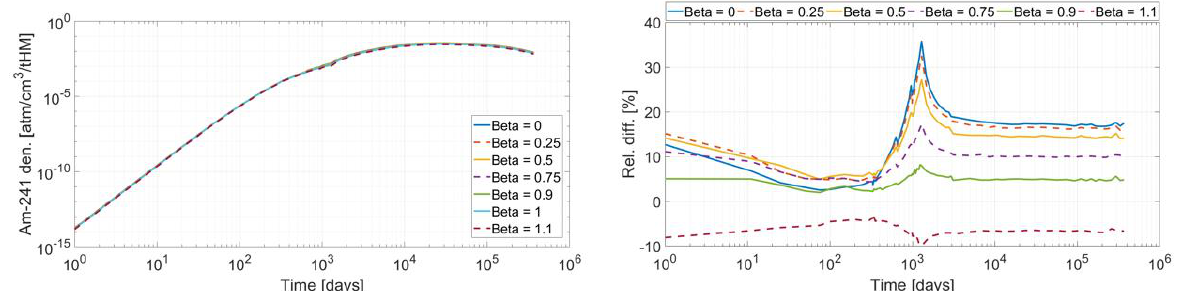
Figure 5. 241 Am mass as a function of irradiation + subsequent cooling time for different albedo boundary